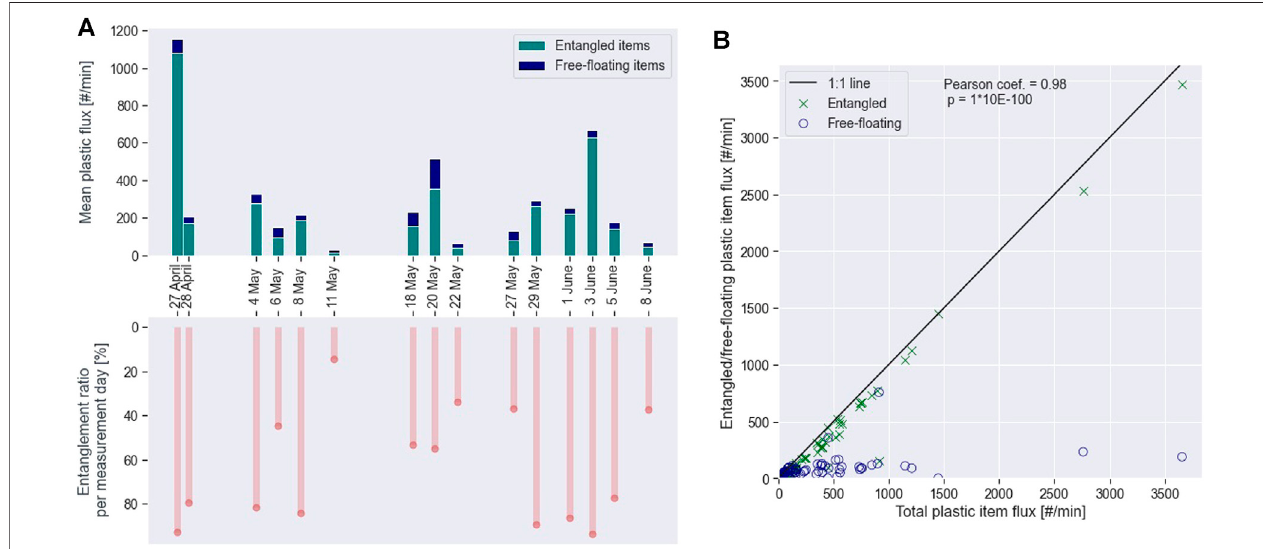
FIGURE 2 | (A) Mean plastic fl ux and entanglement ratios per measurement day as measured from visual observations. (B) Entangled and free- fl oating plastic fl ux in relation to total plastic fl ux. Each data point represents one visual counting observation.